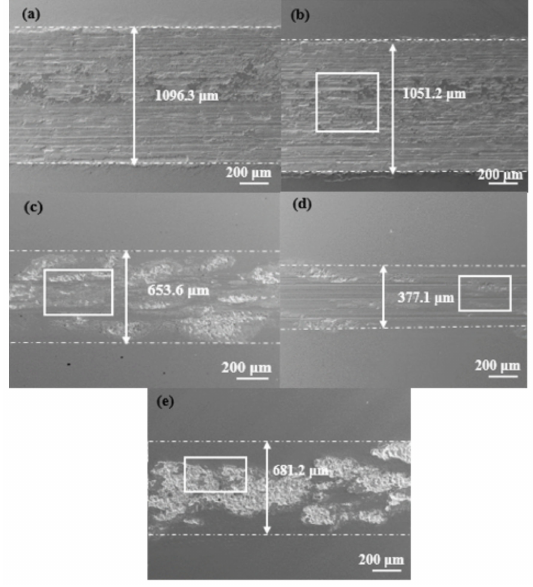
Figure 8. SEM images morphology for wear scars on the ( a ) substrate and TiN coating at R (N 2 ) of ( b ) 0.25, ( c ) 0.35 ( d ) 0.45 ( e ) 0.55 at load of 20 N under unlubricated conditions. White square is the EDS test area.